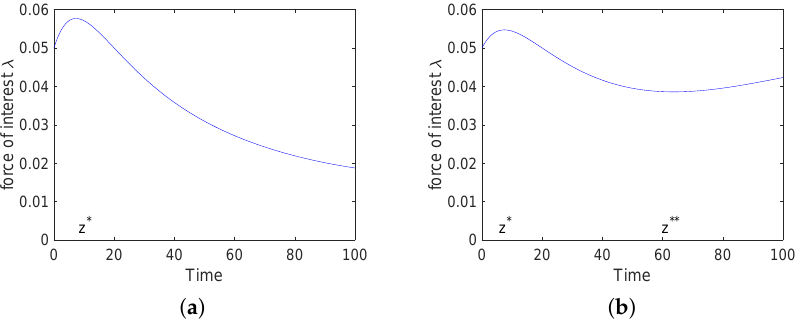
Figure 1. The figure shows the two behaviors of λ for small ( R = 20 ( a )) and high ( R = 1000 ( b )) redemption prices. The other parameters are γ = 0.5, T = 100, δ = 0.05, and m =